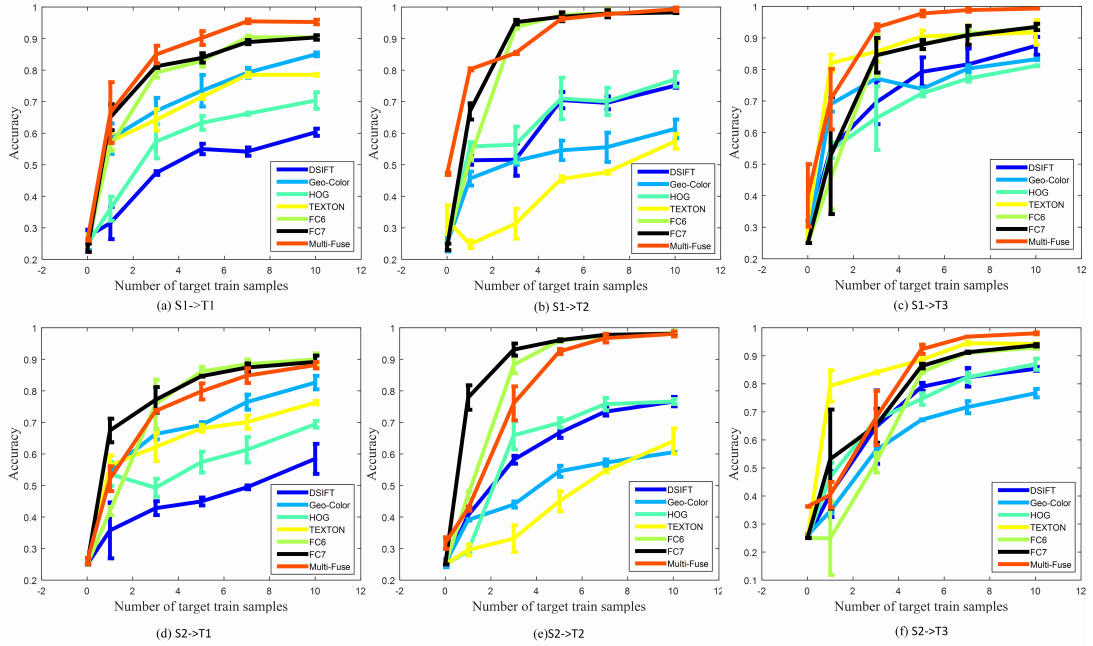
Figure 8. The performance (means and standard deviation of overall accuracy) of our approach with different features for six transfer